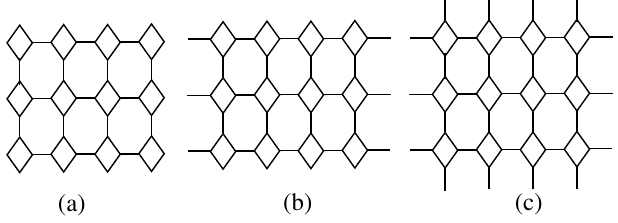
Fig. 1 Nanostructure